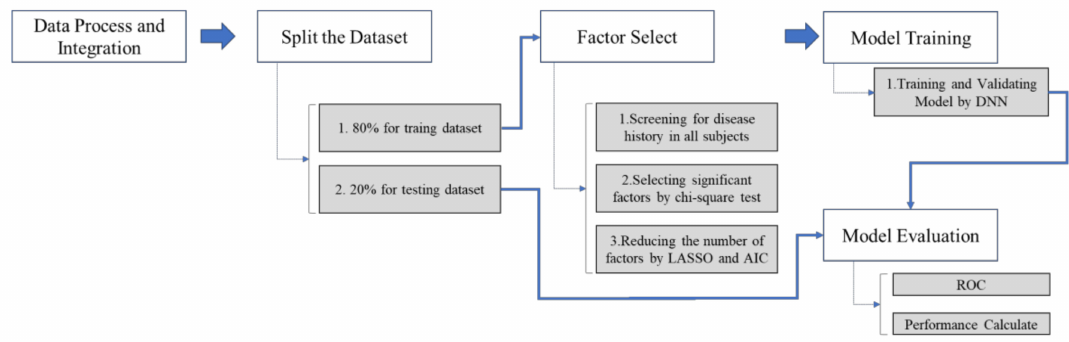
Figure 2. Research